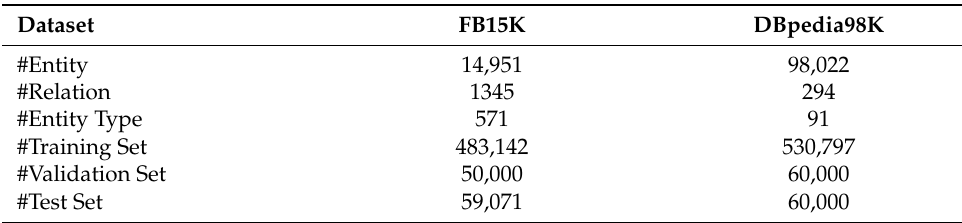
Table 1. Statistics of FB15K and